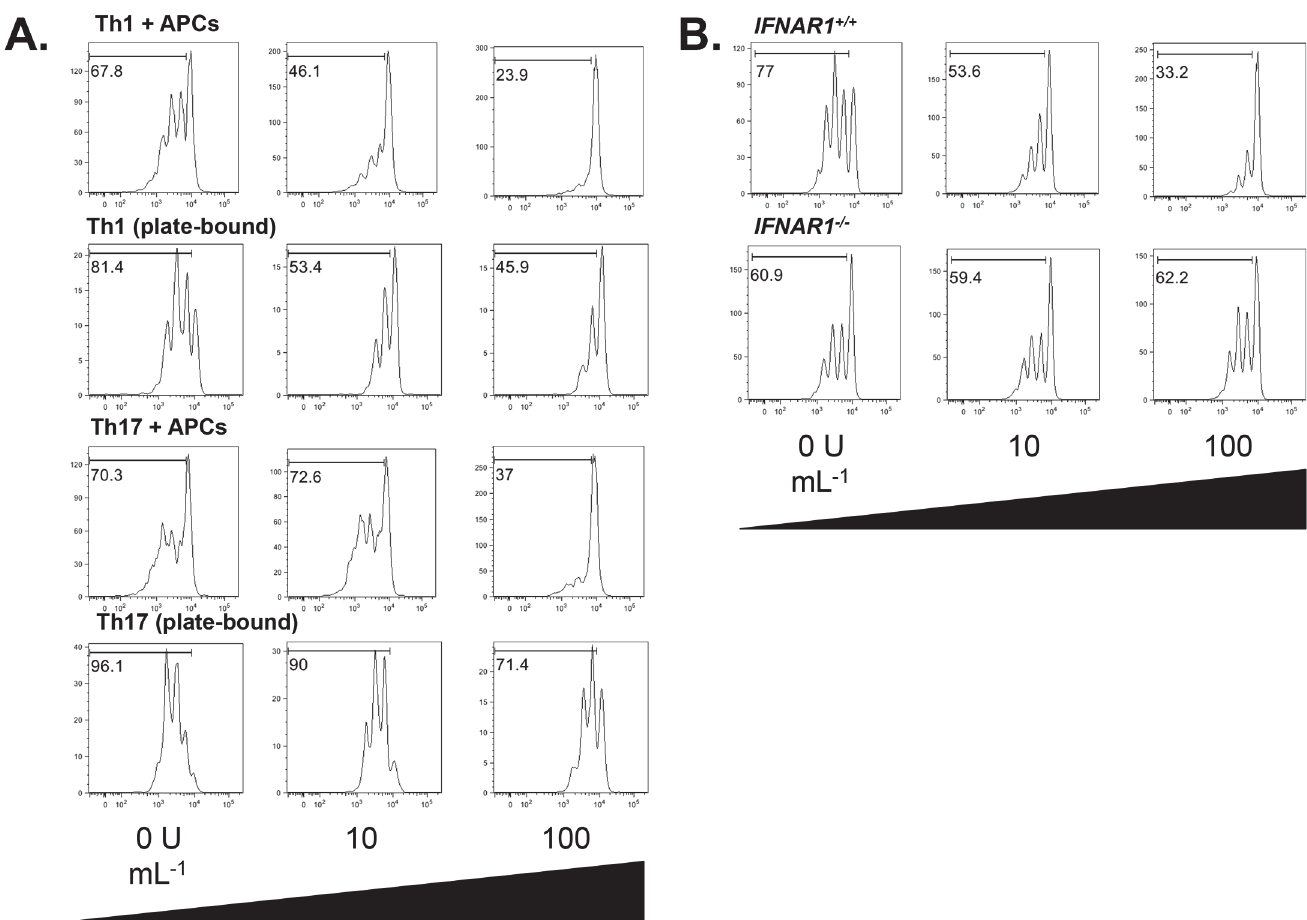
Fig 2. IFN- β suppresses Th1 cell proliferation. A. WT CD4 + CD62L hi T cells were labeled with CFSE and stimulated for 5 days with either soluble anti-CD3 plus irradiated splenocytes (APCs), or with plate-bound anti-CD3+anti-CD28, under Th1 or Th17 conditions, with the indicated concentrations of IFN- β . CFSE dilution was assessed by flow cytometry. Data representative of three experiments. B. WT or IFNAR1-/- CD4 + CD62L hi T cells were labeled with CFSE and stimulated with plate-bound anti-CD3+anti-CD28 under Th1 conditions with the indicated concentrations of IFN- β for 5 days. CFSE dilution was assessed by flow cytometry. Data representative of two experiments. Gates represent the percentage of cells that underwent at least one division.